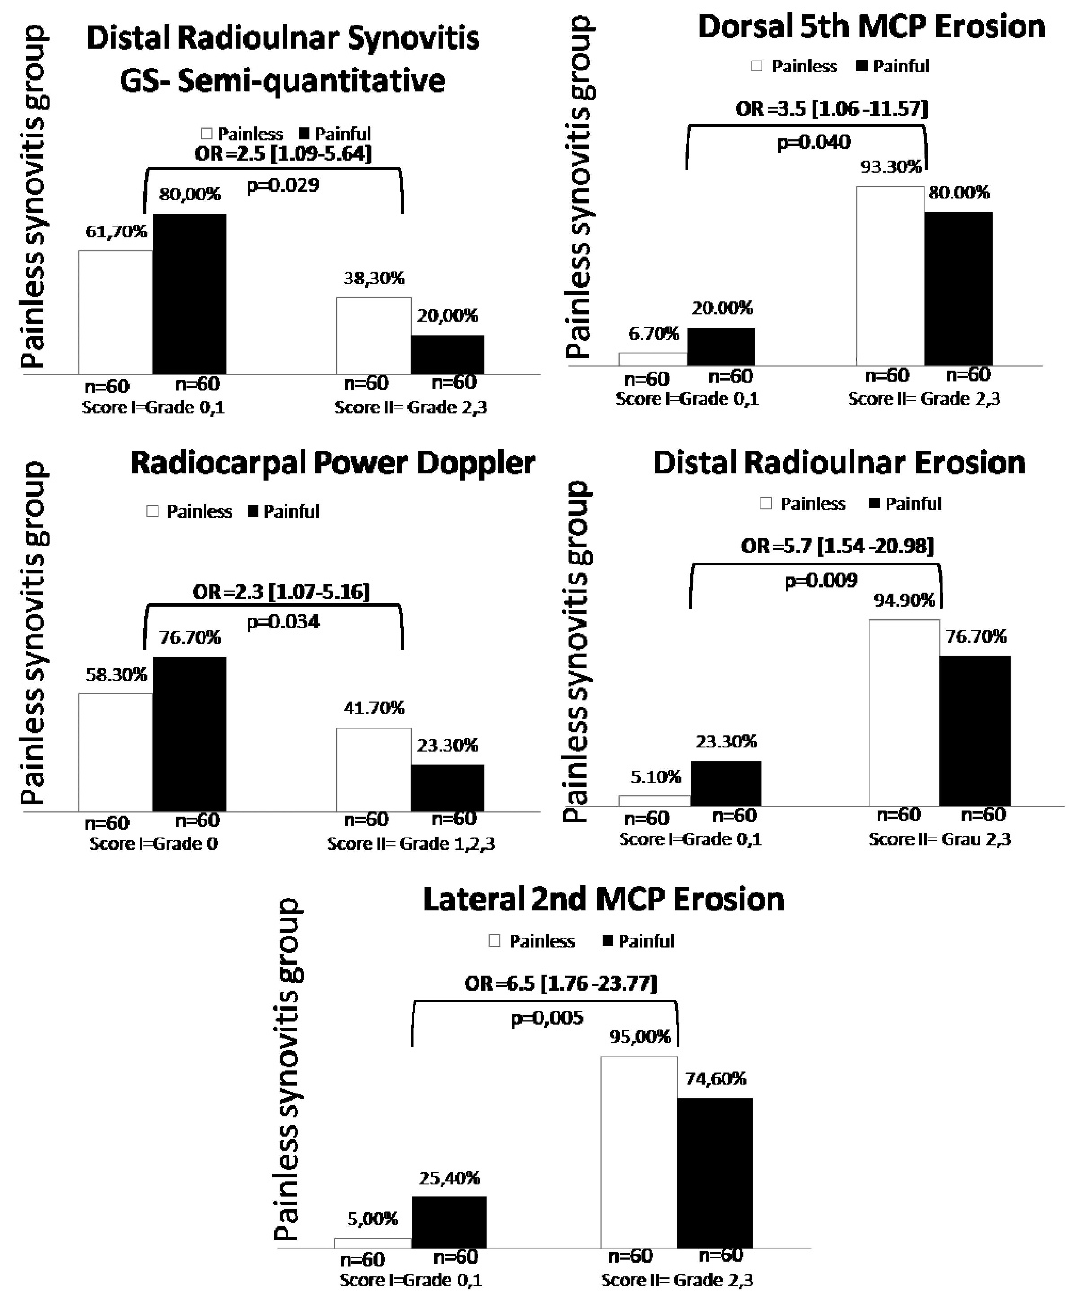
Figure 2 - Probability of belonging to painless synovitis group with presence of Score II semi-quantitative synovial hypertrophy, PD and erosion in relation to Score 1 in joint recesses with statistically significant difference in the previous ultrasonographic evaluation and significant difference in regression analysis (p , 0.05); Statistical test: univariate logistic regression; OR = odds ratio; n